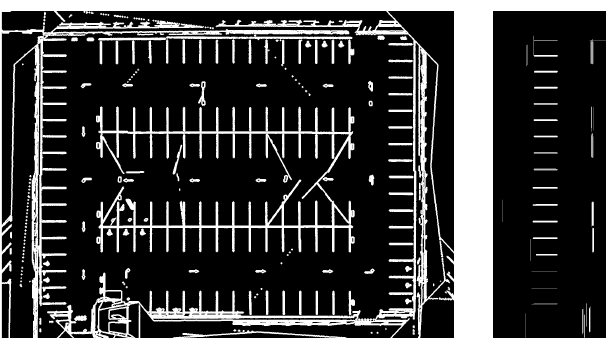
Figure 8. Transformed views of cameras, lookup table illustration, and fused aerial view image. ( a – c ) and ( e – g ) show the transformed view of cameras produced through IPM. ( d ) shows the fused aerial view image generated using transformed views and the camera lookup table.